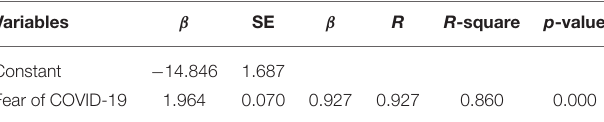
TABLE 6 | Fear of COVID-19 as the predictor of emotional distress among nurses ( N = 500). Variables β SE β R R -square p -value Constant − 14.846 1.687 Fear of COVID-19 1.964 p <